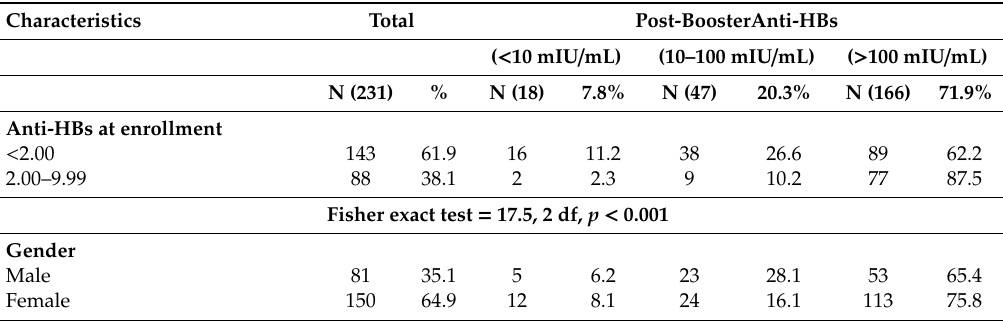
Table 3. Characteristics of subjects tested after the booster dose stratified by a post-booster anti-HBs titer.